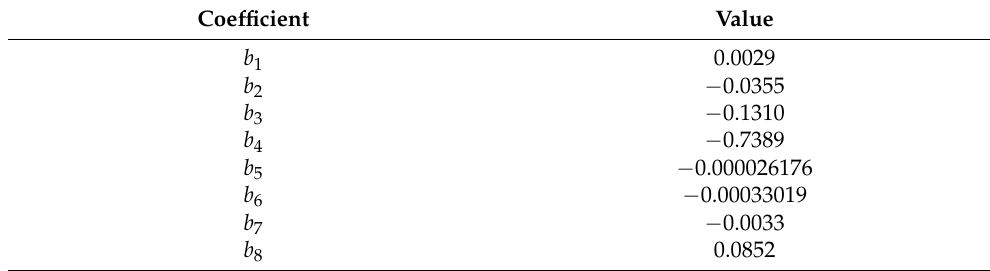
Table 2. Coefficients of the expression approximating the clutter loss statistics for H S = 4–6 m.